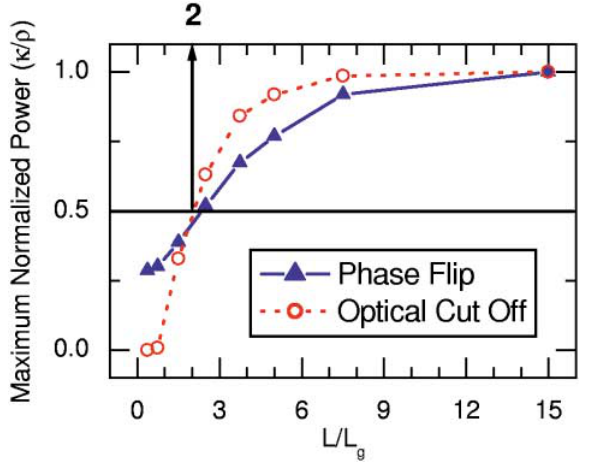
FIG. 5. (Color) Achievable power as a function of the undulator length per segment. The two cases of misalignment are